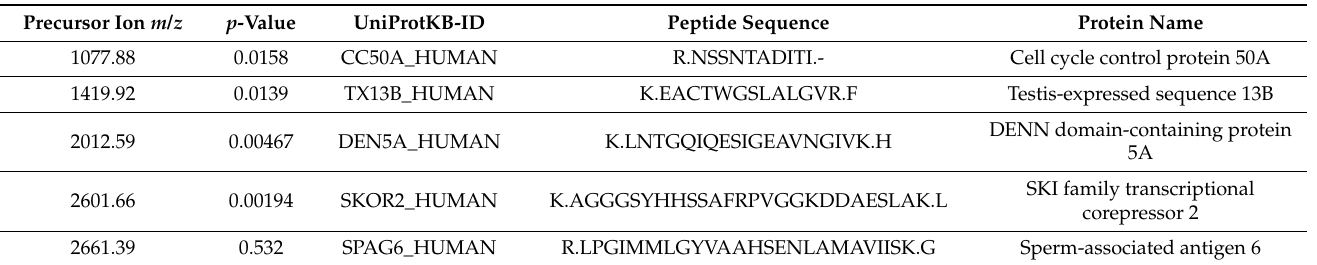
Table 4. Identified proteins differentiating the study